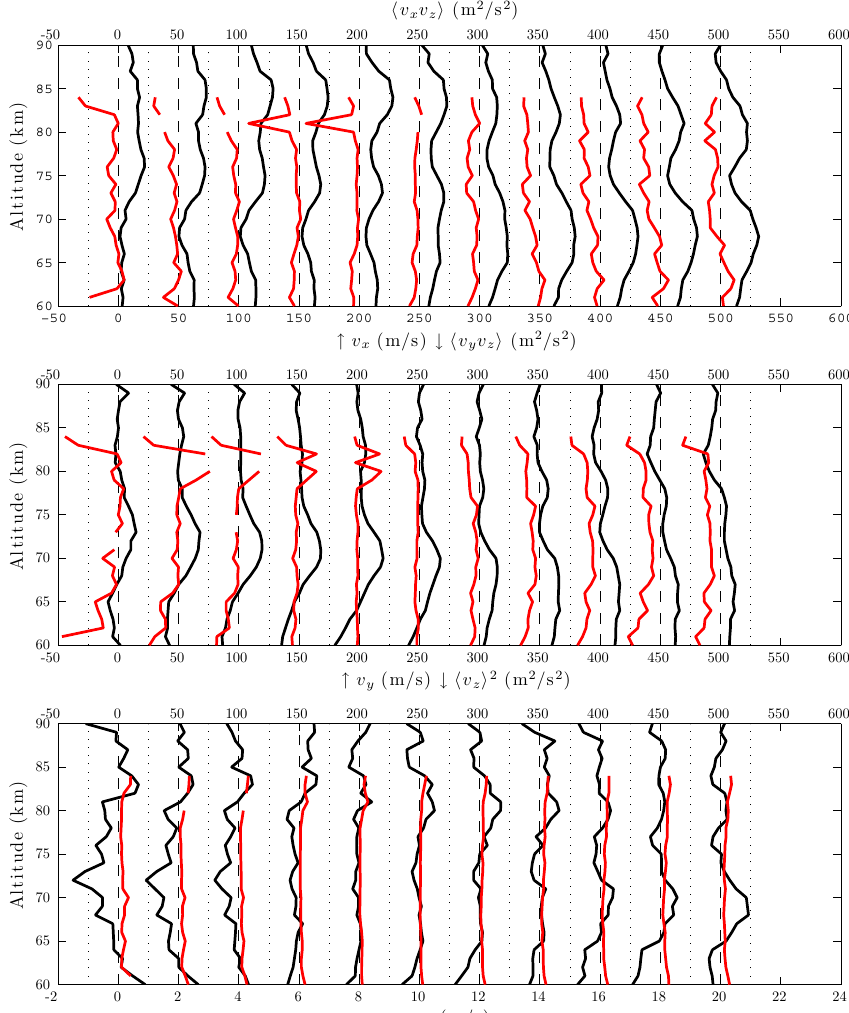
Fig. 10. Same as Fig. 8 for the period 18:00–24:00UT on 21 December 2007. Note that momentum fluxes and vertical velocity variance spacing is 50m 2 s − 2 .